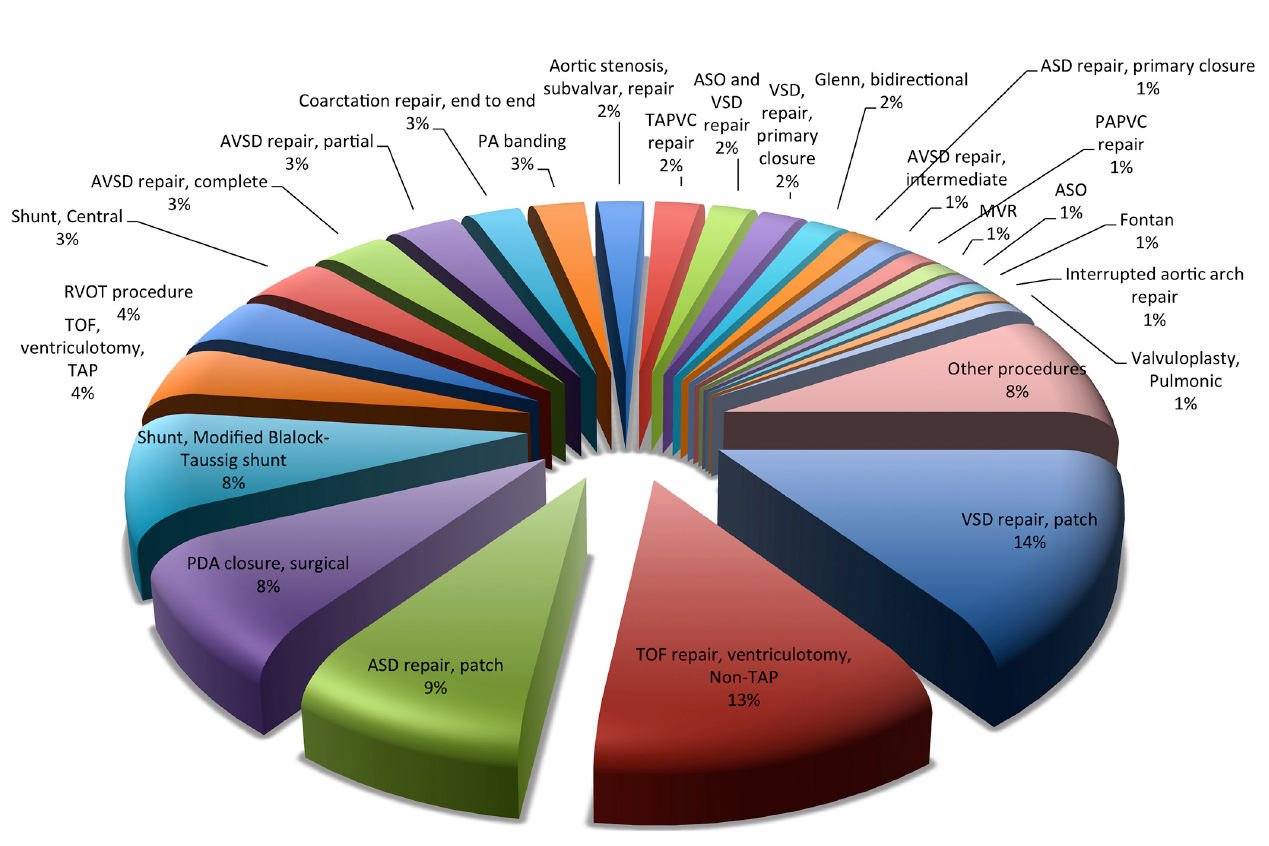
Fig. 2 - Distribution according to the nomenclature of the procedures proposed by Aristotle score. Graph showing the variability of the treated patients between surgical cases. To facilitate the graphical representation of the total sample, 15 different procedures grouped under 2 cases in the entire period under “Other procedures" (<2 cases).